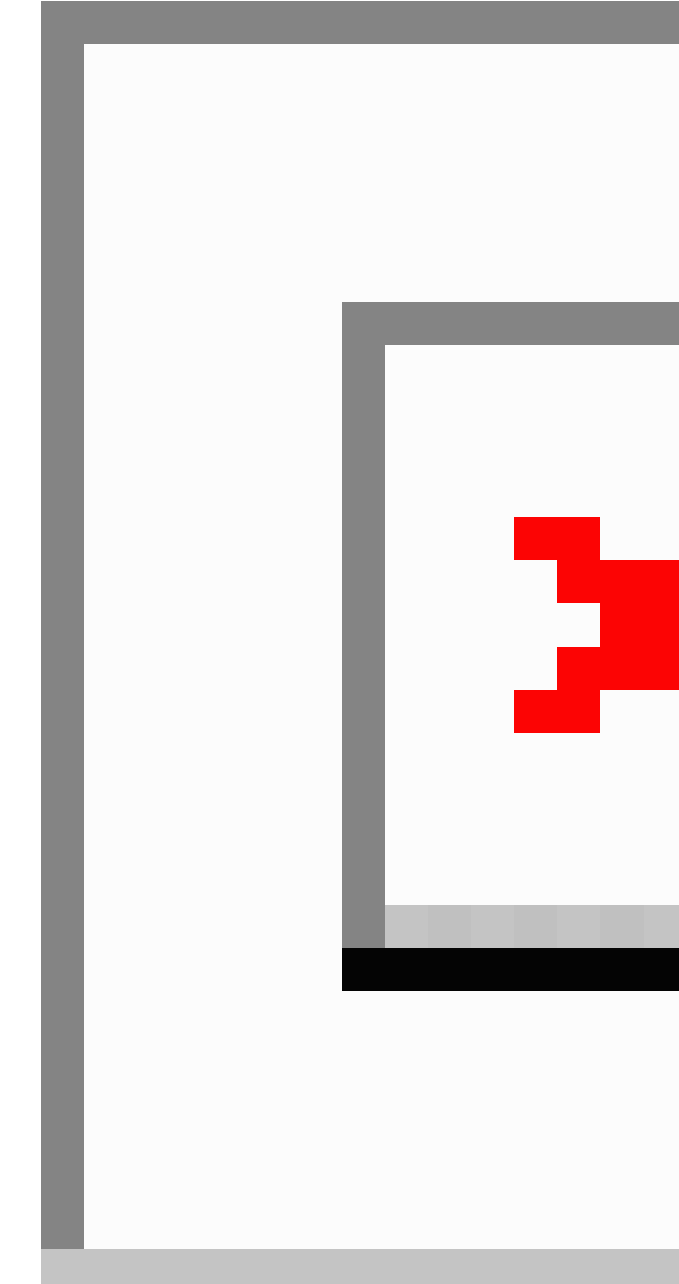
Figure 4. Proportion of missed appointments at medical practice